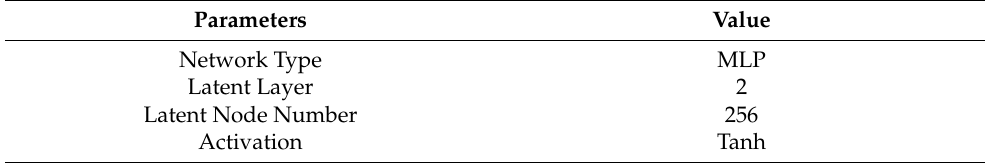
Table 1. Neural Network Hyper